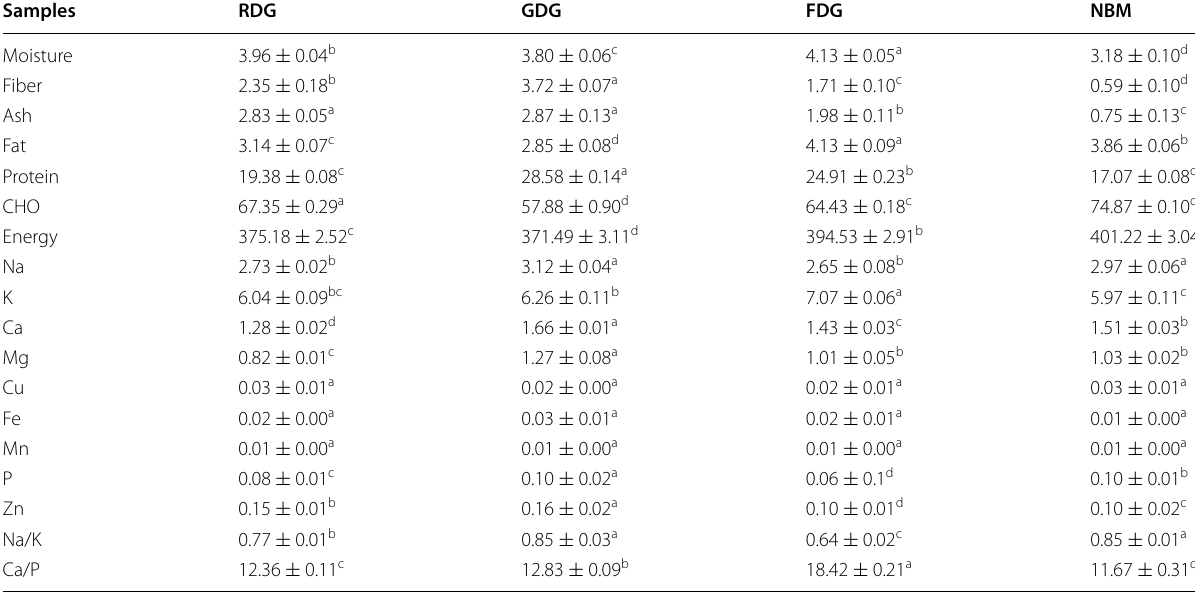
RDG Raw maize, defatted groundnut and ginger in ratio 76.7:20.8:2.5 GDG Germinated maize, defatted groundnut and ginger in ratio 74.4:23.1:2.5 FDG Fermented maize, defatted groundnut and ginger in ratio 72.6:24.9:2.5 NBM Nutribom (a commercial maize-based complementary food) Means ( SEM) with different alphabetical superscripts in the same row are significantly different at P < ±